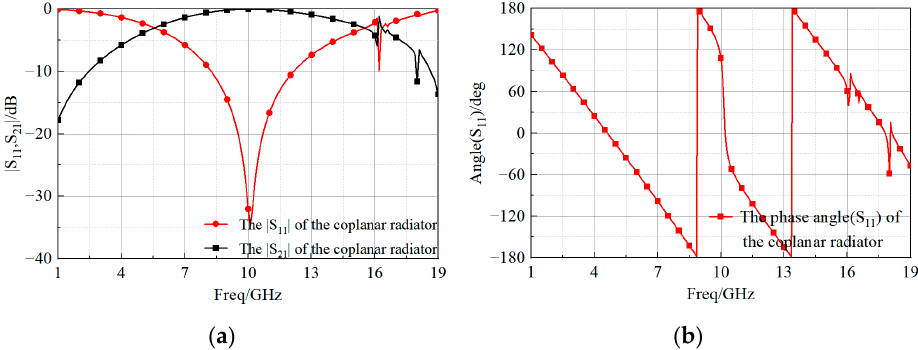
Figure 4. Values of the ( a ) magnitude and ( b ) phase of the reflection coefficient of the coplanar radiator.